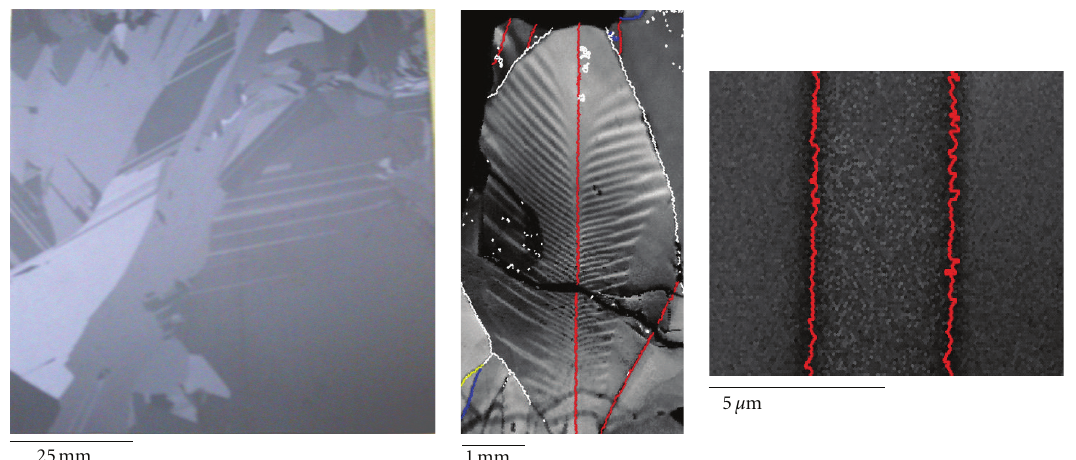
Figure 11: Mc-Si wafer (left) and faceted dendrite crystal examined by EBSP analysis (right) [43].